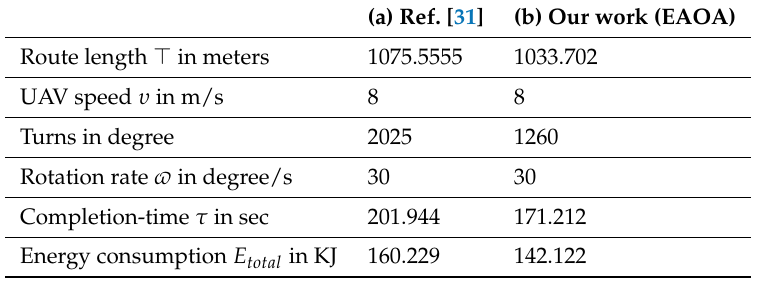
Table 2. Results obtained by CPP in Ref. [31] (Figure 22a) vs. EAOA (Figure